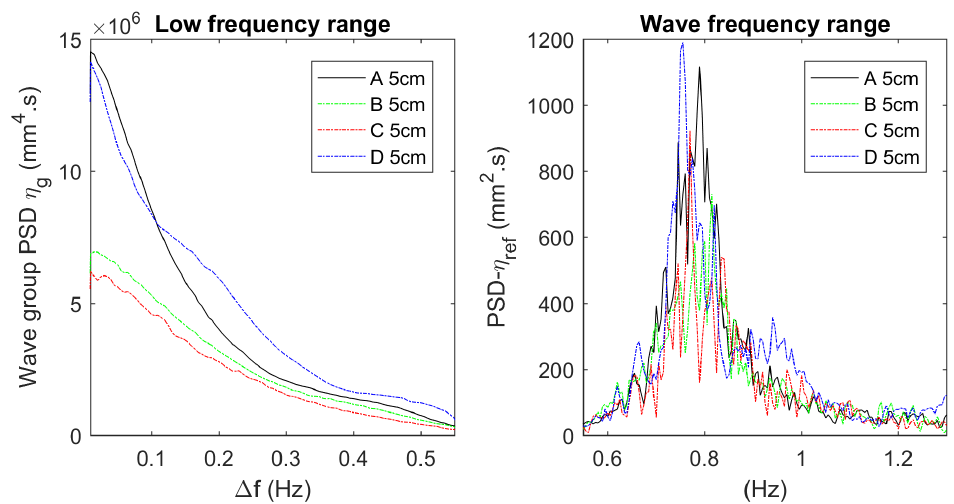
Figure 3. Realised wave spectra for JONSWAP T p = 1.29 s and H s = 5 cm: in the low frequency range ( left ) and in the wave frequency range ( right